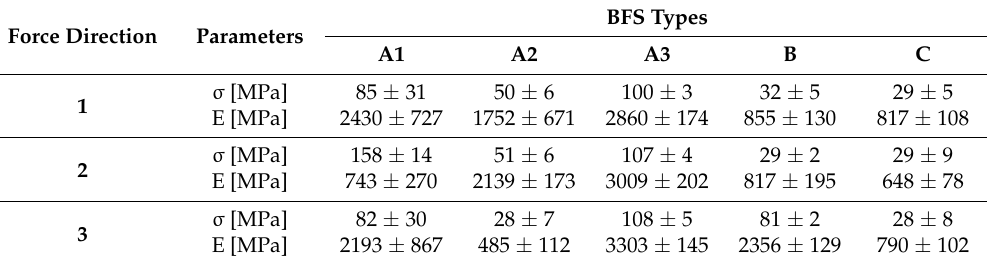
Table 2. Process parameters used to manufacture test specimens